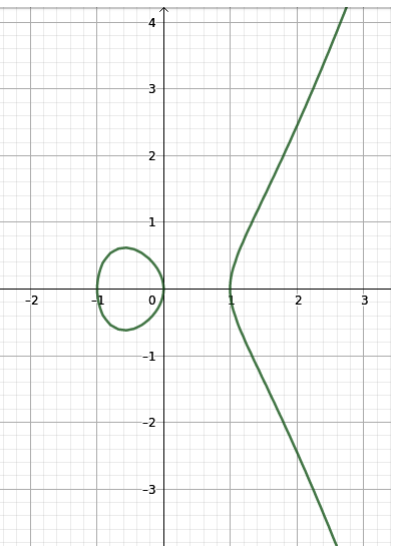
Figure 1. An elliptic